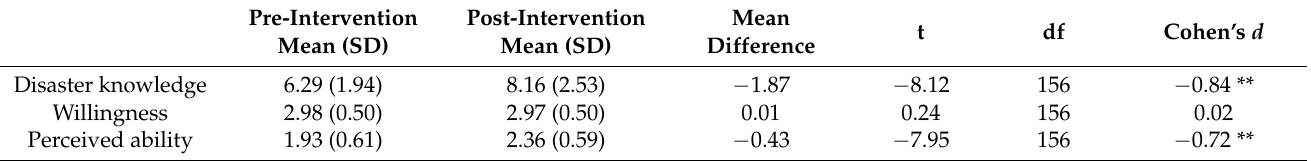
Table 2. Comparison between pre- and post-intervention for various measurements.